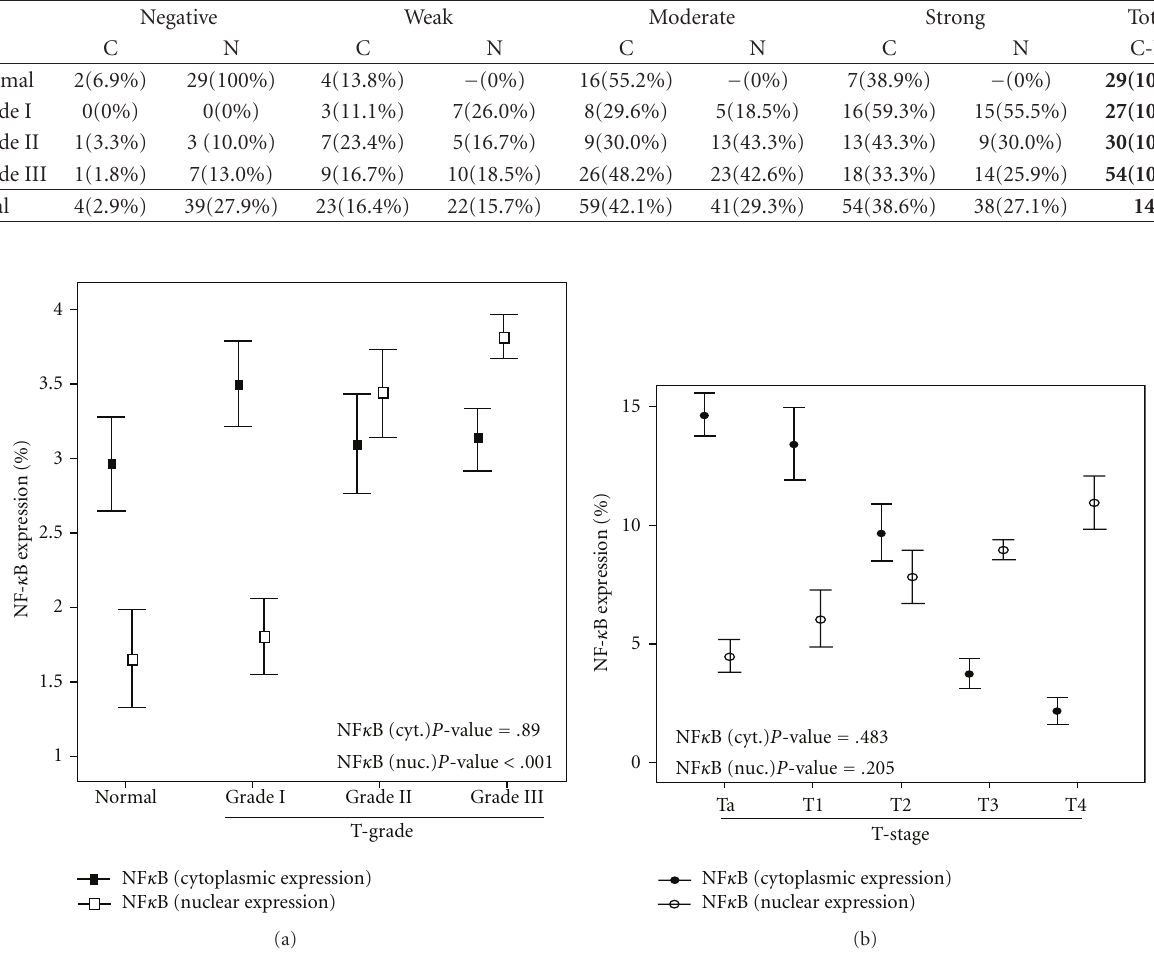
Figure 3: NF κ B nuclear (white box) and cytoplasmic (black box) expression, stratified by (a) tumor grade and (b) tumor stage. Nuclear expression of NF κ B was more frequent, during tumor dedi ff erentiation. (error bars = standard error of the value). Table 4: Coexpression of COX-2 and NF κ B of cytoplasmic (C) and nuclear (N). Positive correlation was established between expression of COX-2 and nuclear staining of NF κ B during progression of